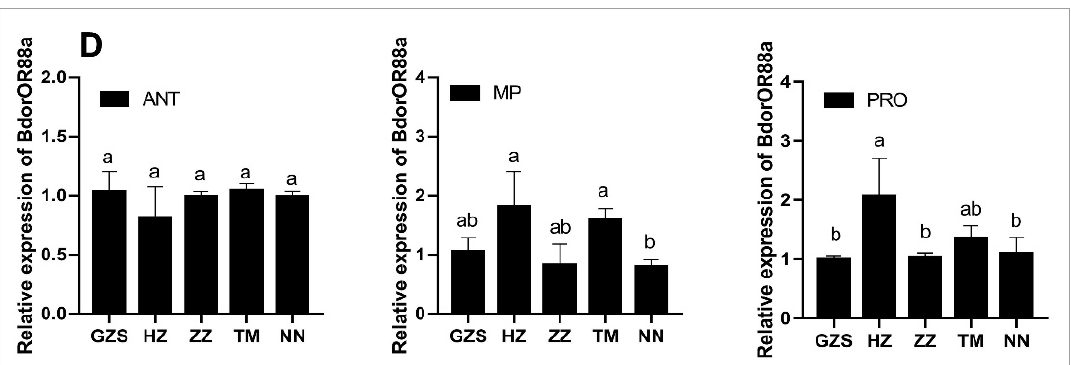
Figure 2. Expression profiles of four genes in the antennae (ANT), maxillary palps (MP) and proboscis (PRO) of B. dorsalis males from the GZS susceptible strain and the four field populations ( A ) BdorOBP2, ( B ) BdorOBP83b, ( C ) BdorOrco, and ( D ) BdorOR88a. Relative gene expression was measured by qRT ‒ PCR, and values represent the means ± SEs for three independent replicates. Different letters on the histogram bars indicate significant differences based on one ‐ way ANOVA followed by Tukey’s HSD multiple comparison test ( p < 0.05).